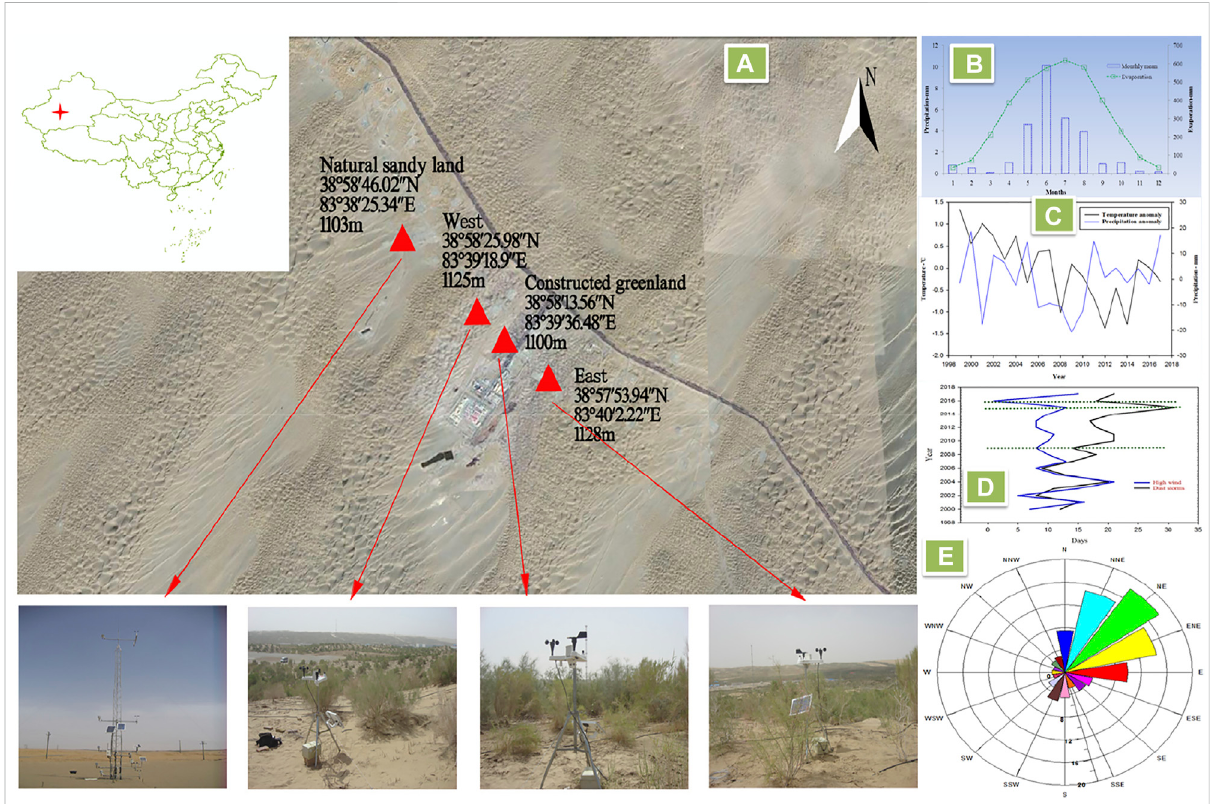
FIGURE 1 Researchareaoverviewandarrangementoftheexperimentsites( A) Distributionofthefourstations, (B) meanannualprecipitationandmonthly variations in evaporation at the Tazhong weather station, (C) annual precipitation and temperature anomalies during 1998 – 2018 at Tazhong, (D) annual variations in strong sandstorm days at Tazhong, and (E) direction frequency of strong wind for multiple